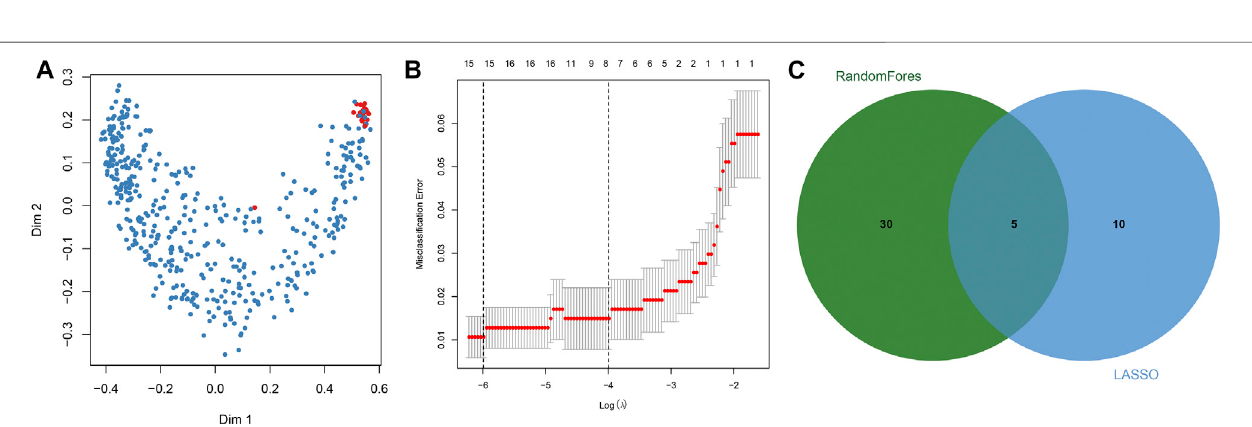
FIGURE 2 | Screening of diagnostic DNA methylation (DNAm) markers in gastric cancer. (A) Multi-dimensional scaling plot of the proximity matrix generated from randomforestanalysisinthetrainingdataset.Reddotsrepresentnormalsamplesandbluedotsindicatetumor samples. (B) Misclassi fi cationerrorfordifferentnumbers ofvariablesrevealedbytheLASSOregressionmodel.Reddotsrepresentthevalueofmisclassi fi cationerror,greylinesrepresentthestandarderror(SE),thetwovertical dottedlinesontheleftandrightrepresentoptimalvaluesbytheminimumand1-SEcriteria,respectively. “ Lambda ” isthetuningparameter. (C) ScreeningofDNAm markersforreliablediagnosis.Thegreencirclerepresentsrepresentative DNAmmarkersselectedbyrandomforestanalysis,andthebluecircleindicates representative DNAm markers screened by LASSO regression analysis.